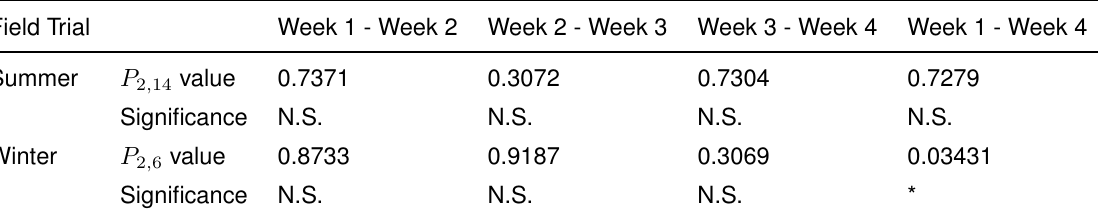
Table 3. Weight gain statistics. * indicates P value below 0.05, ** indicates P value below 0.01, *** indicates P value below 0.001, N.S. indicates no statistically significant difference between the diets.